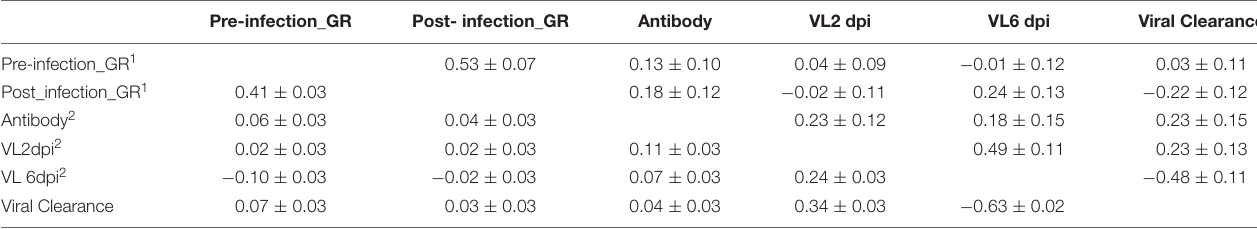
TABLE 3 | Estimates ( ± SE) of genetic (above diagonal) and phenotypic (below diagonal) correlations for the Ghana local chicken ecotypes population based on bivariate